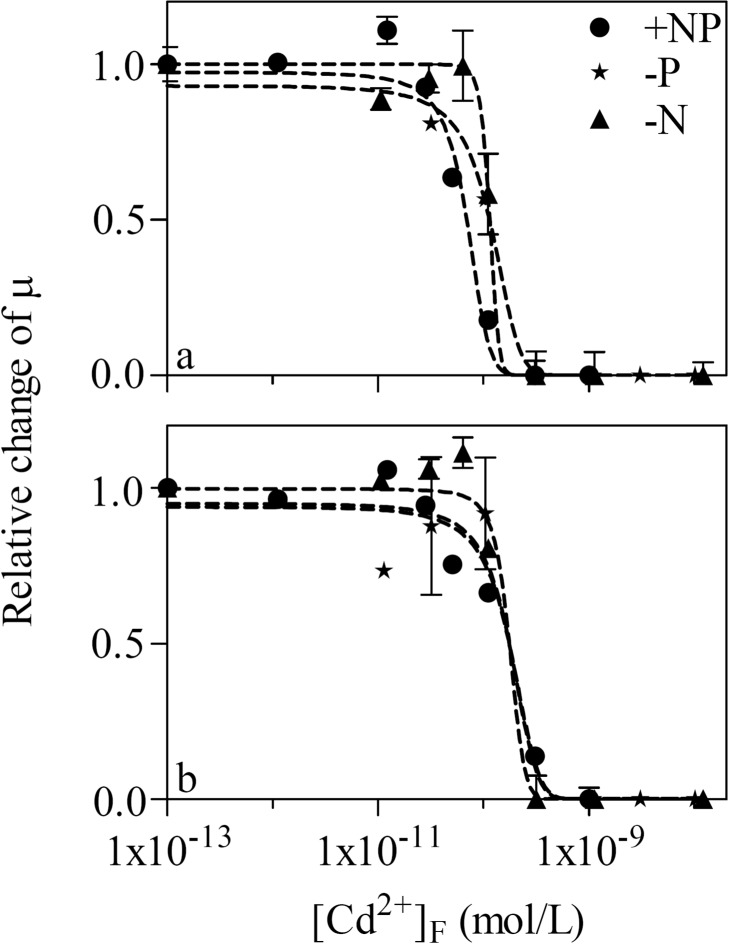
Relative change of the cell specific growth rate (μ) in treatments with different free Cd ion concentration ([Cd2+]F, 1.00×10-13—1.21×10-8 M) as compared to its counterpart in the respective control treatment of the nutrient-enriched (+NP, circle), phosphorus-limited (-P, star), and nitrogen-limited (-N, triangle) toxicity tests for (a) Microcystis aeruginosa PCC 7806 (WT) and (b) its MC-lacking mutant (MT).Dashed lines are dose-response curves simulated by the Logistic model. Data are mean ± standard error (n = 2)